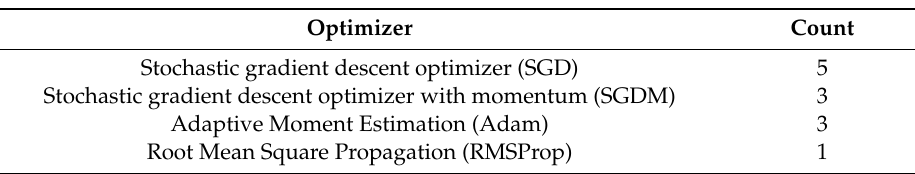
Table 6. Optimizer